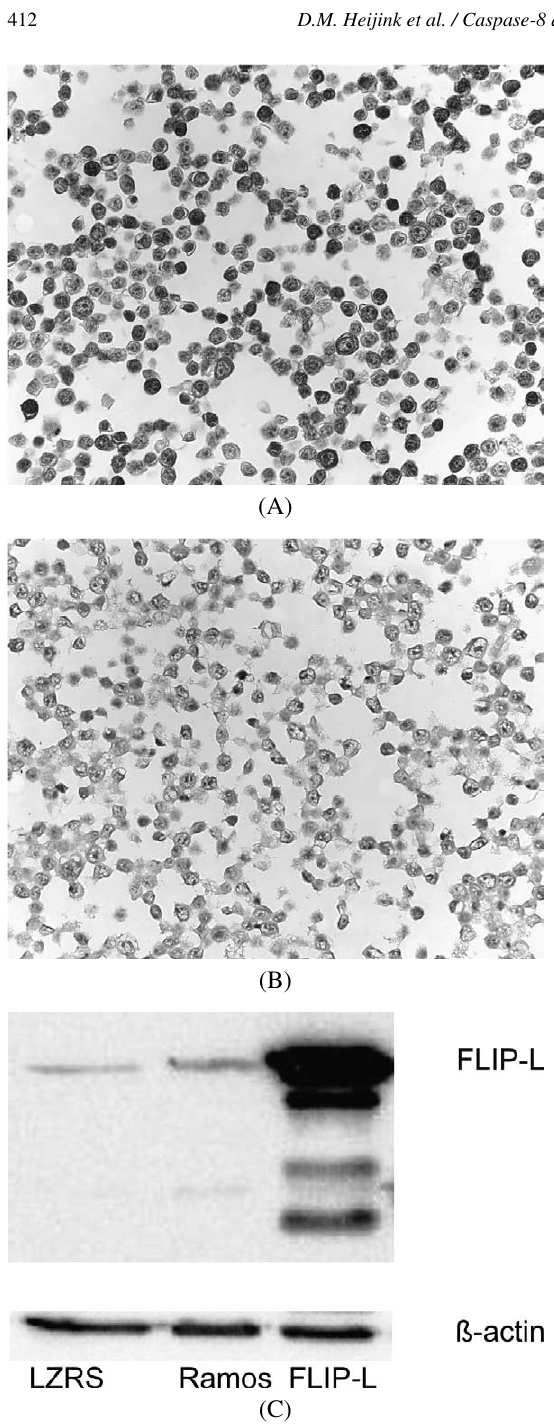
Fig. 1. Control model for cFLIP staining. (A) Strong cFLIP stain- ing in cFLIP L overexpression cell line. (B) Weak FLIP staining in Ramos cell line. (C) Western-blot analyses for cFLIP confirming dif- ferences in cFLIP expression between cFLIP L overexpression cell line and Ramos cell line; the extra bands probably represent splice